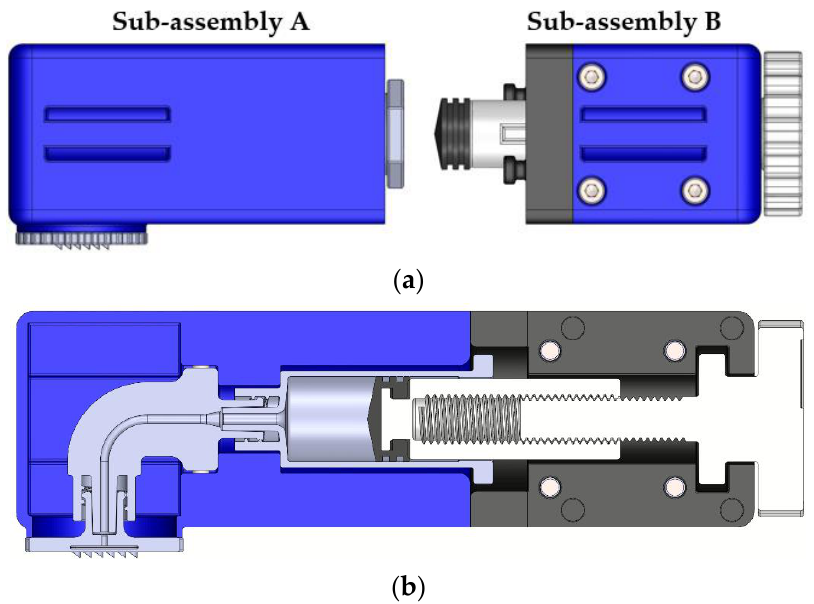
Figure 1. ( a ) Preparation for connection of A and B sub-assemblies; ( b ) sectional view of the drug delivery apparatus.